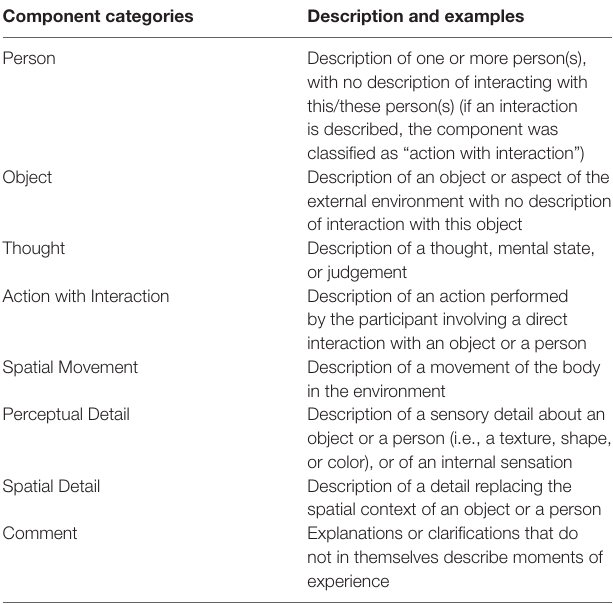
TABLE 2 | Descriptions and examples of scored experience unit